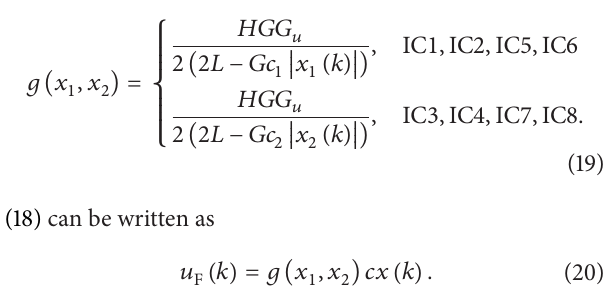
Table 1: Outcomes of fuzzy rules in IC regions. IC